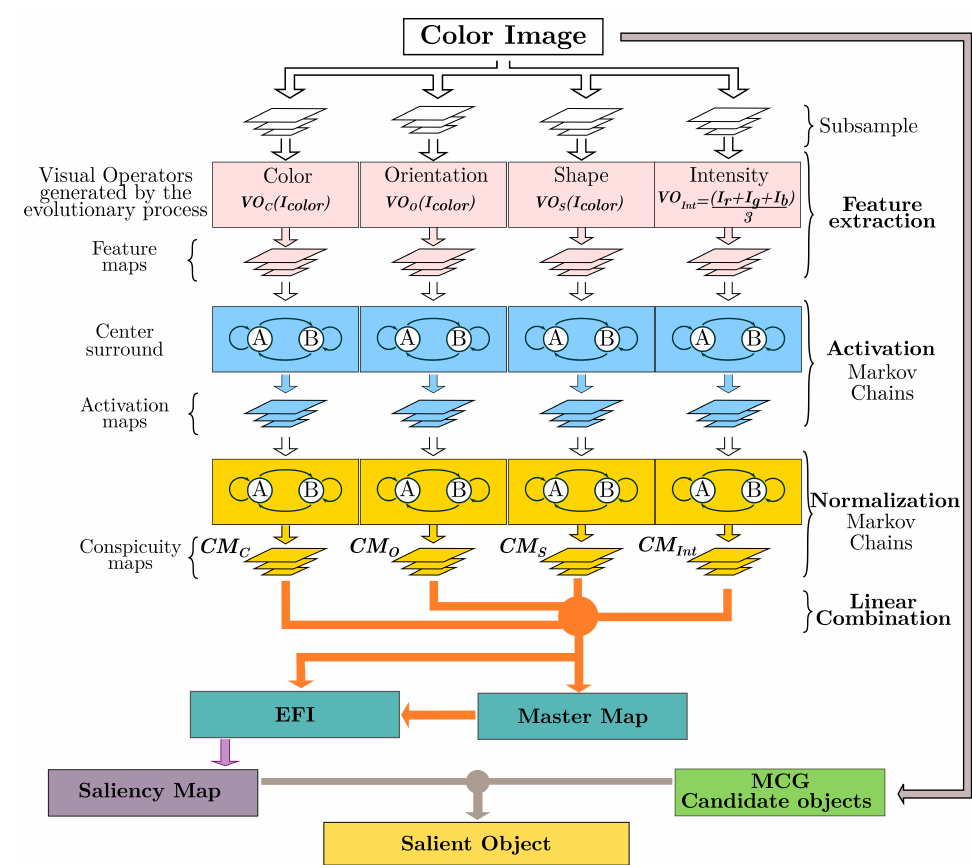
Figure 1. Brain programming implementation of the dorsal stream using the combination of visual saliency and image segmentation algorithms. We propose discovering a set of visual operators ( VOs ) and the evolutionary feature integration (EFI) within the template through artificial evolution. The whole design makes a design balance between the human designer (deductive reasoning) and the computer (symbolic